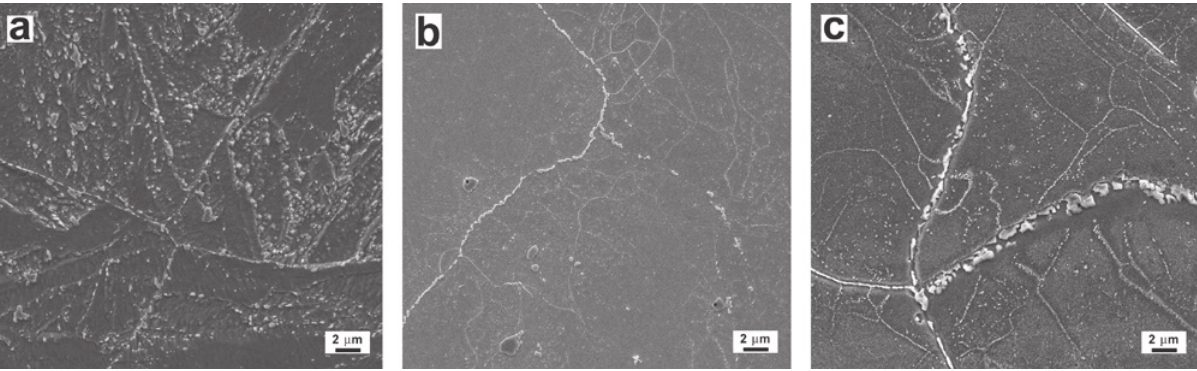
Fig. 3: SEM microstructures of different regions of the T91/TP316H weldment after long-term annealing at 600 °C for 5000 h: T91 steel HAZ